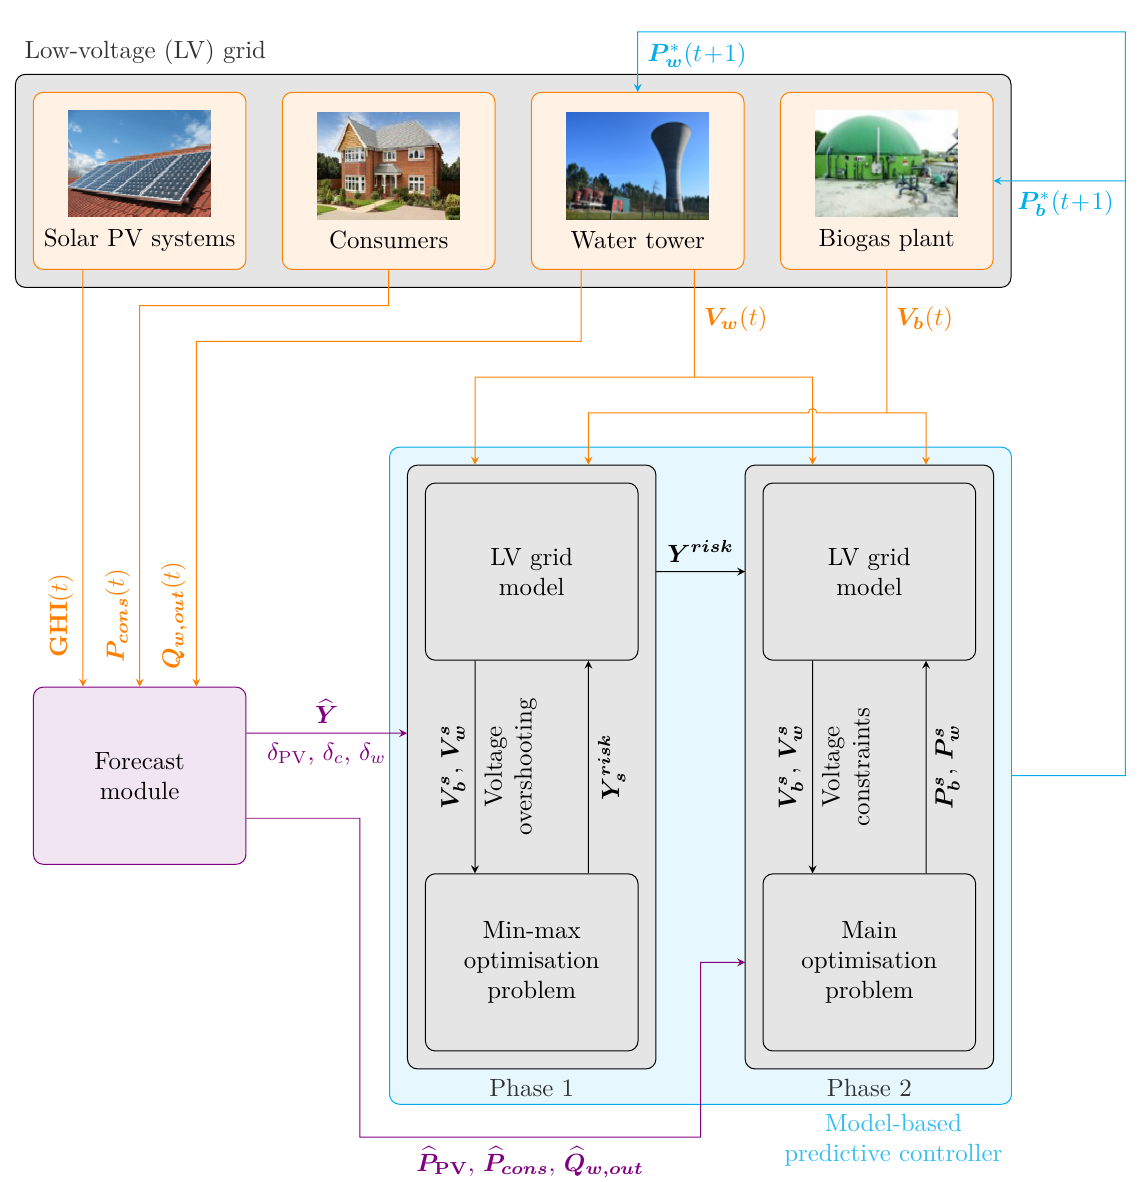
Figure 3. Synoptic scheme of the amended MPC-based strategy for smart management of a low-voltage power distribution grid using flexible assets. Let GHI , P cons , Q w , out , V w , V b be measurements of global horizontal irradiance, grid load, water demand, water volume, and biogas volume, respectively. Let (cid:98) Y be forecasts of stochastic inputs for the following time steps. Let δ PV , δ c , δ w be margins that define confidence intervals for the next time step of GPR forecasts of PV power generation, grid load, and water demand, respectively. Let (cid:98) P PV , (cid:98) P cons , (cid:98) Q w , out be forecasts of PV power generation, grid load, and water demand over the forecast horizon, respectively. Let Y risk s and Y risk be candidate values and optimal values of worst-case scenario stochastic inputs. Let P s and P s w be candidate values of biogas plant setpoints and water tower b setpoints, respectively. Let V s and V s w be the biogas volume and the water volume, respectively, corresponding to the b candidate optimisation variables of a given